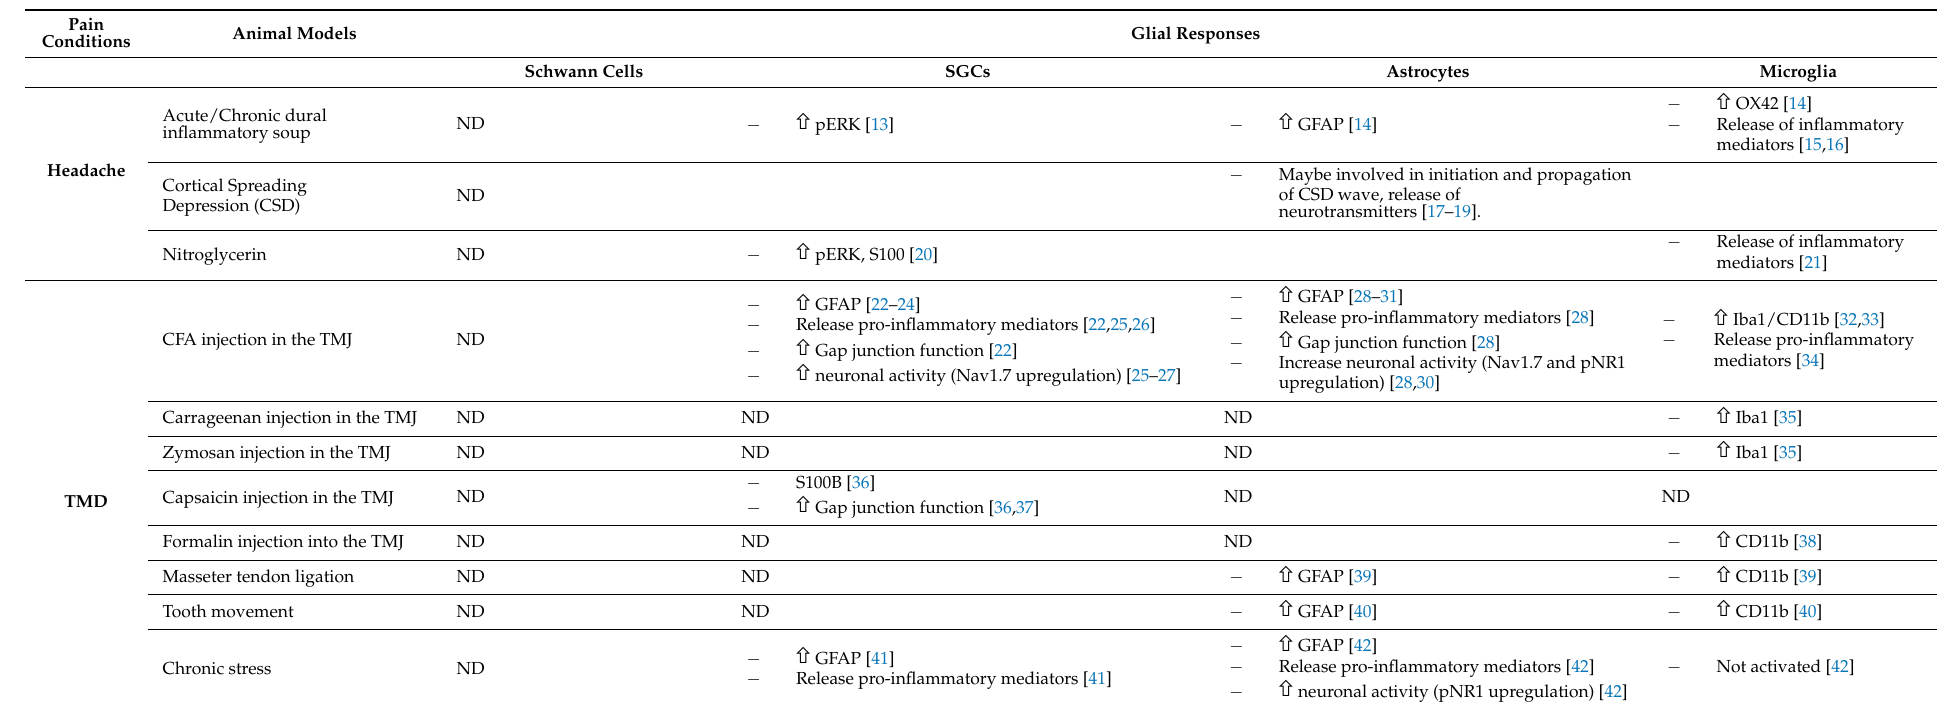
Table 1. Animal models and model-specific glial responses.